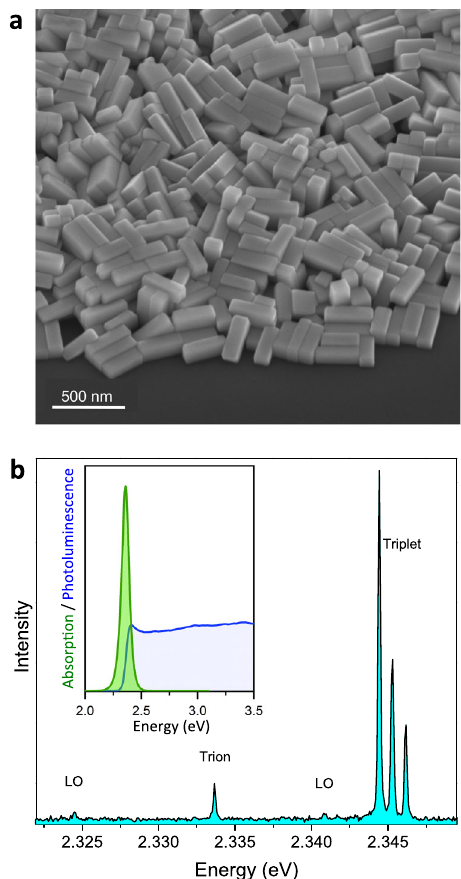
Fig. 1 | Characterization of the large OGB-capped CsPbBr 3 NCs. a 45°-Scanning electron microscopy image of the OGB-capped CsPbBr 3 NCs. Their room- temperature absorption and emission spectrum is shown in the inset of b . b Representative PL spectrum of a single NC at 3.5K under laser excitation with wavelength 488nm and intensity 50Wcm − 2 (integration time 10s).